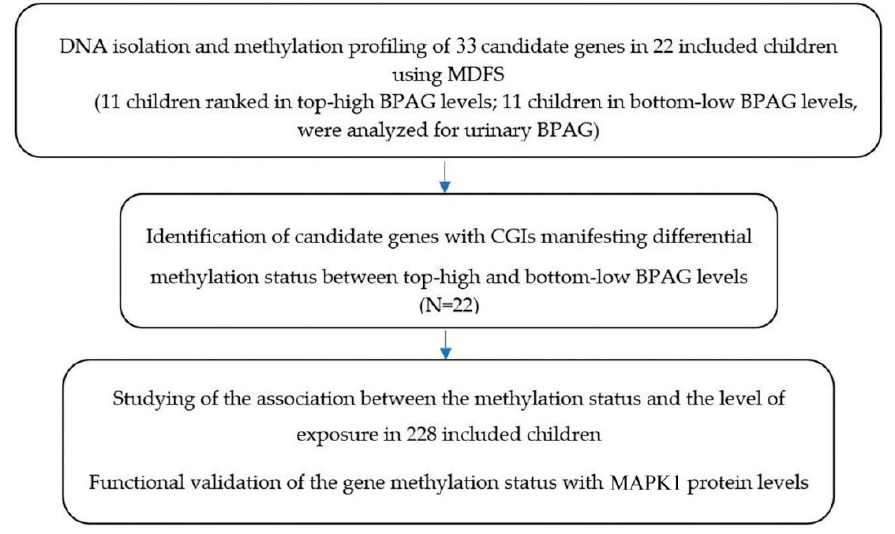
Figure 1. Flow chart describing this study.